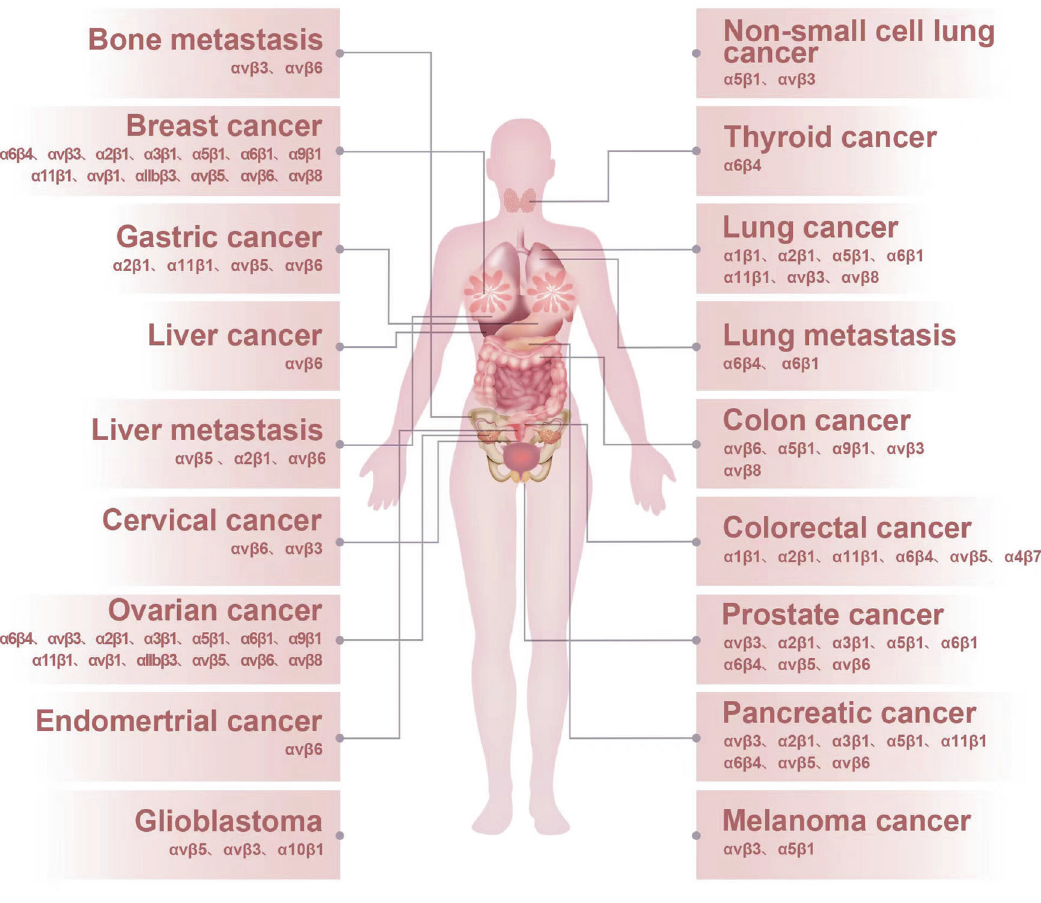
Fig. 5 The expression and function of major integrins and their related cancer types and metastatic sites. The expression of integrins can vary considerably between normal and tumor tissue and is also associated with cancer types and organotrophic